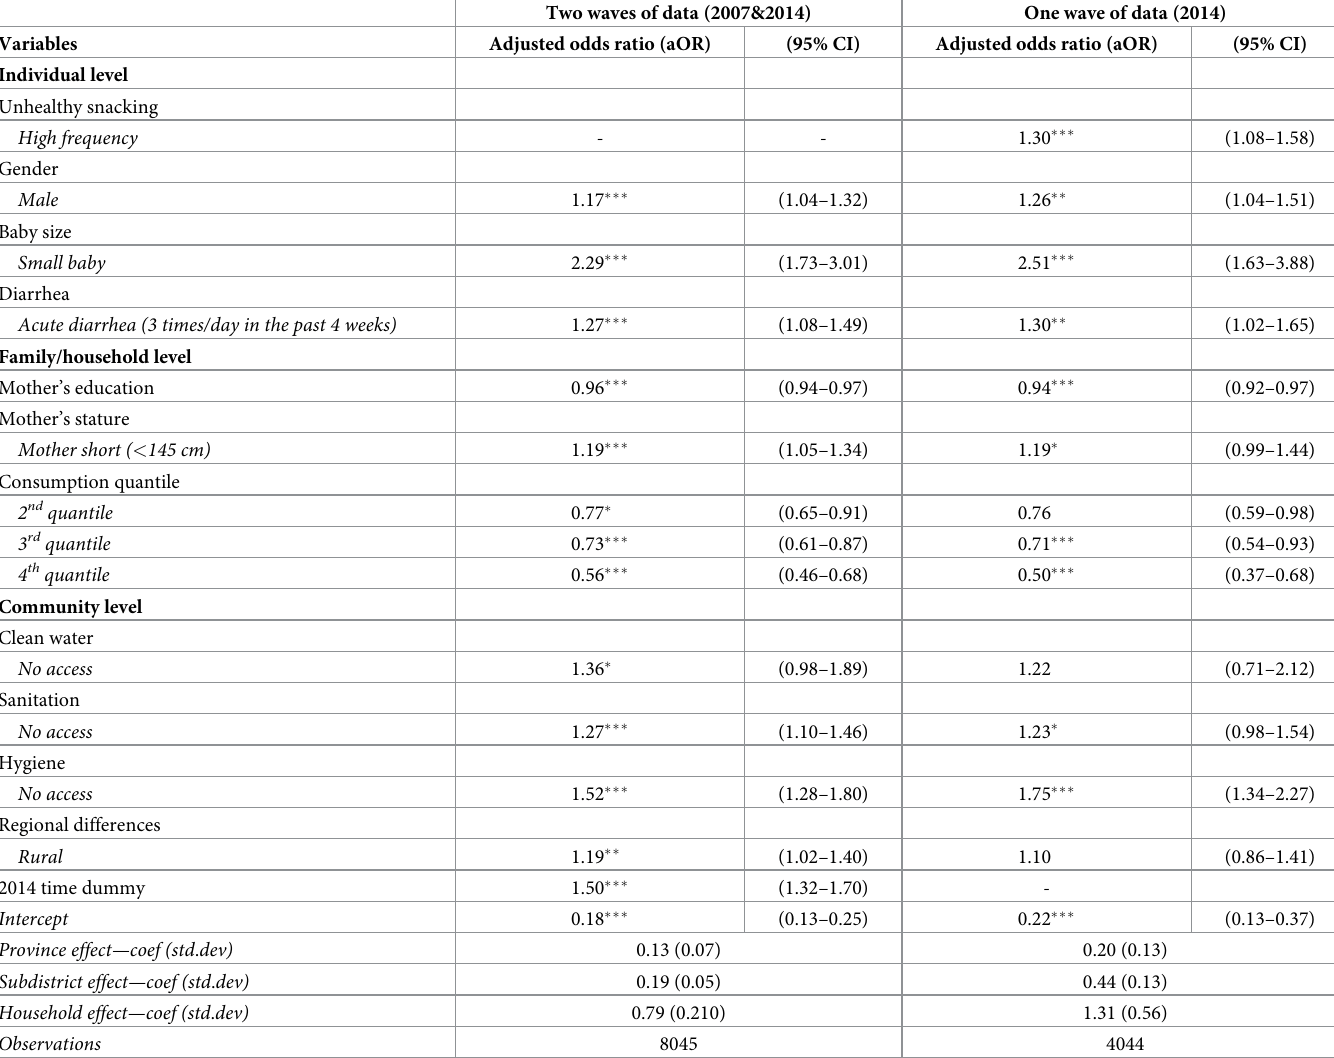
Table 3. Multilevel mixed effects model logistic regression results of stunting